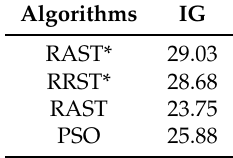
Table 6. Information gathering of the autonomous surface vehicle (ASV) in field